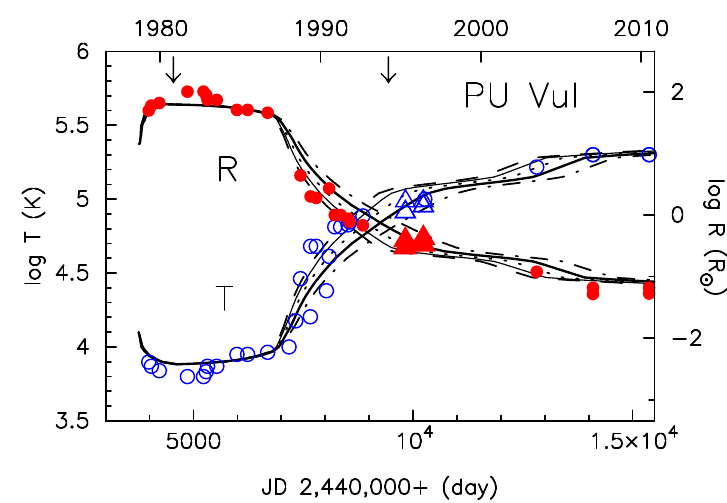
Fig. 2. Development of the temperature (open symbols and the left ordinates) and ra- dius (filled symbols and the right ordinates) of the hot component of PU Vul. Lines denote the blackbody temperatures and radii of the 0.6 M ⊙ WD photosphere with X = 0 : 7 and Z = 0 : 01 for five different wind mass-loss rates. Dash-dotted lines: 4 (cid:2) 10 − 7 M ⊙ yr − 1 , thick solid lines: 5 (cid:2) 10 − 7 M ⊙ yr − 1 , dotted lines: 6 (cid:2) 10 − 7 M ⊙ yr − 1 , thin solid lines: 7 (cid:2) 10 − 7 M ⊙ yr − 1 and dashed lines: 8 (cid:2) 10 − 7 M ⊙ yr − 1 . Two downward arrows indicate the central times of two